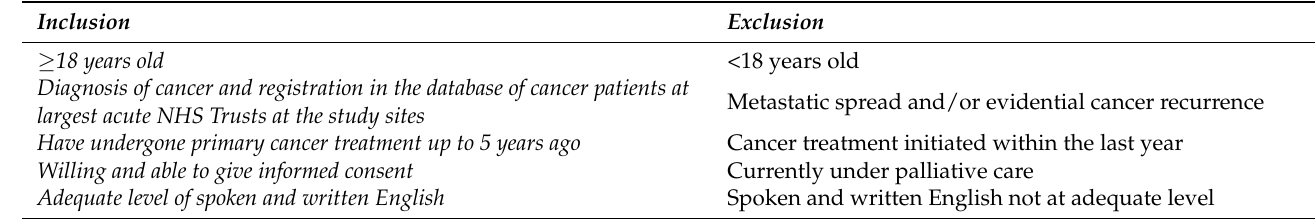
Table 1. Participant eligibility